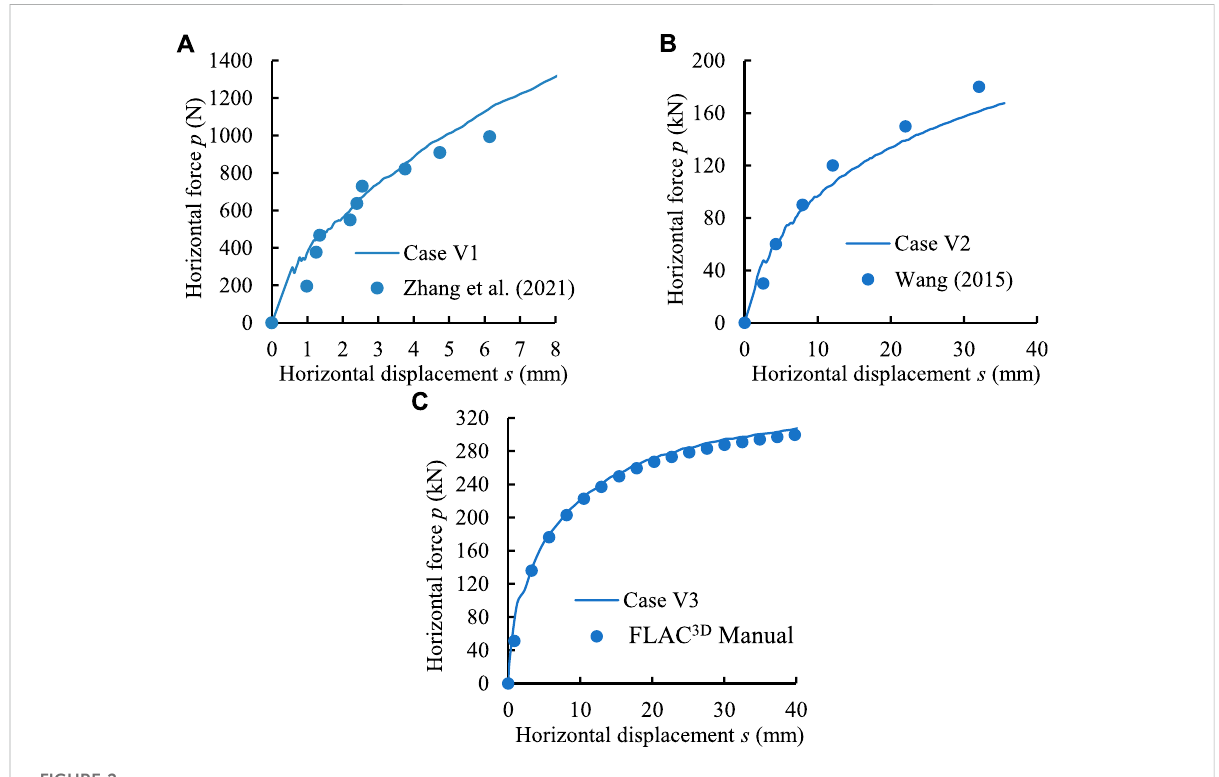
FIGURE 2 Comparisons between the numerical results obtained in the present study with experimental results of (A) Zhang et al. (2021) and (B) Wang (2015), and (C) numerical results in FLAC 3D Manual.